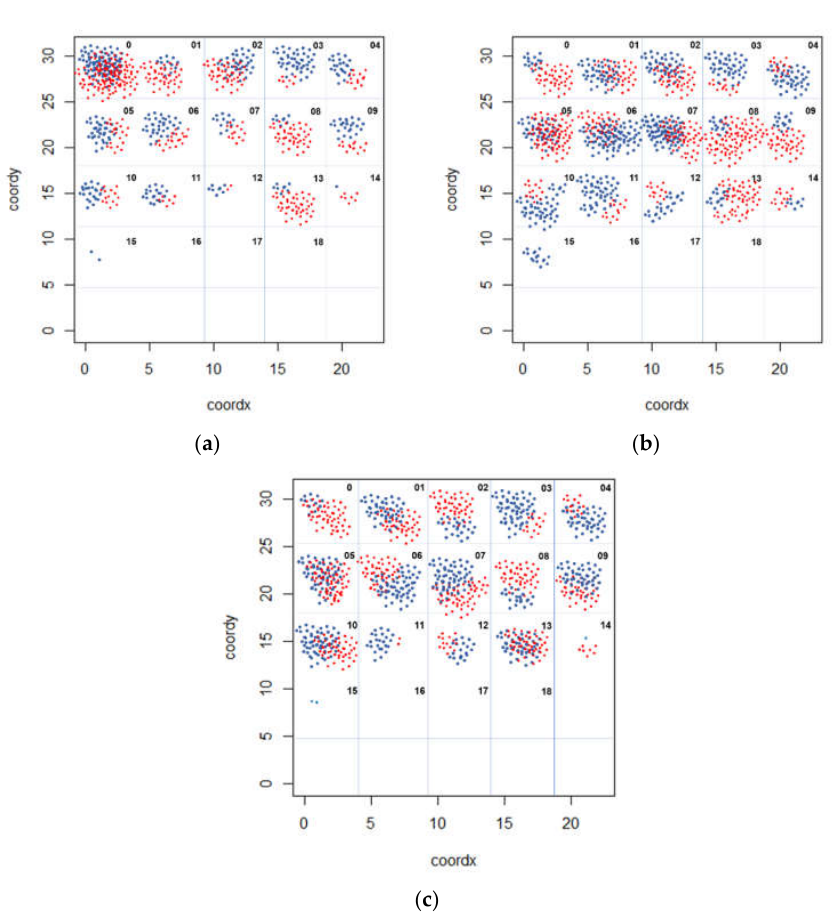
Figure 6. Grid map of the frequency positioning of the animals (primiparous cows—blue dot; multiparous cows—red dot), at 09:00 and 12:00 h ( a ), between 12:00 and 15:00 h ( b ), and between 15:00 and 18:00 h ( c ).